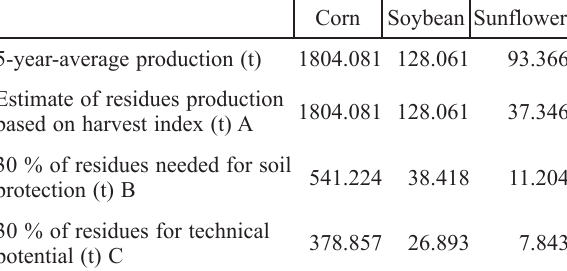
Table 2 – Average production of corn, soybean and sunflow- er in Croatia for a 5-year period (2010–2014)